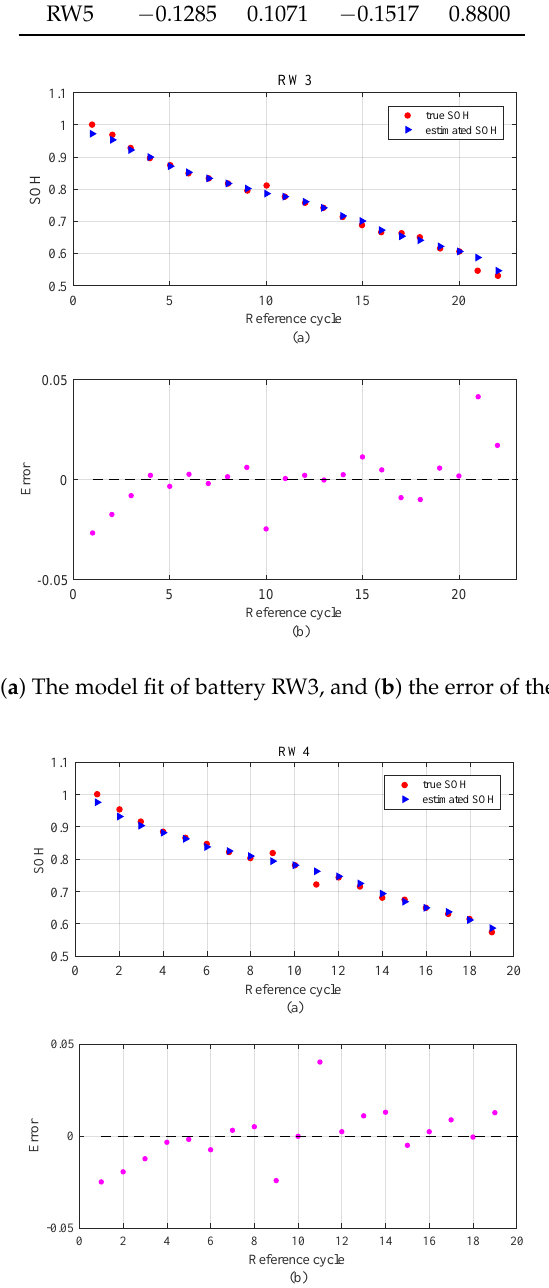
Figure 11. ( a ) The model fit of battery RW4, and ( b ) the error of the model